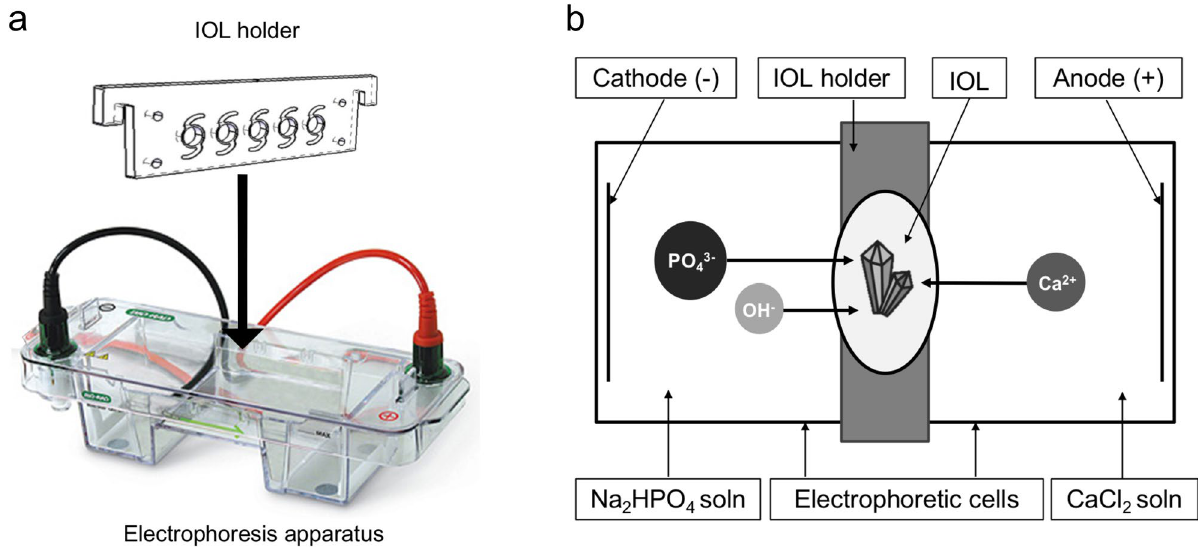
Figure 1. Schematic illustration of experimental setup ( a ) and hydroxyapatite formation within the intraocular lens (IOL) polymer ( b ). ( a ) The IOLs were placed in the double-walled holder having a circular opening exposing the IOL’s surfaces. The holder was then placed in the electrophoresis tank with a rubber seal to avoid leakage of the solutions. ( b ) The disodium phosphate aqueous solution was set at the cathode side and the calcium chloride aqueous solution at the anode side. Calcium cations and phosphate anions migrate toward the corresponding electrode side—passing through the IOL polymer. Hydroxyapatite was formed as the opposing ions met in the gel.